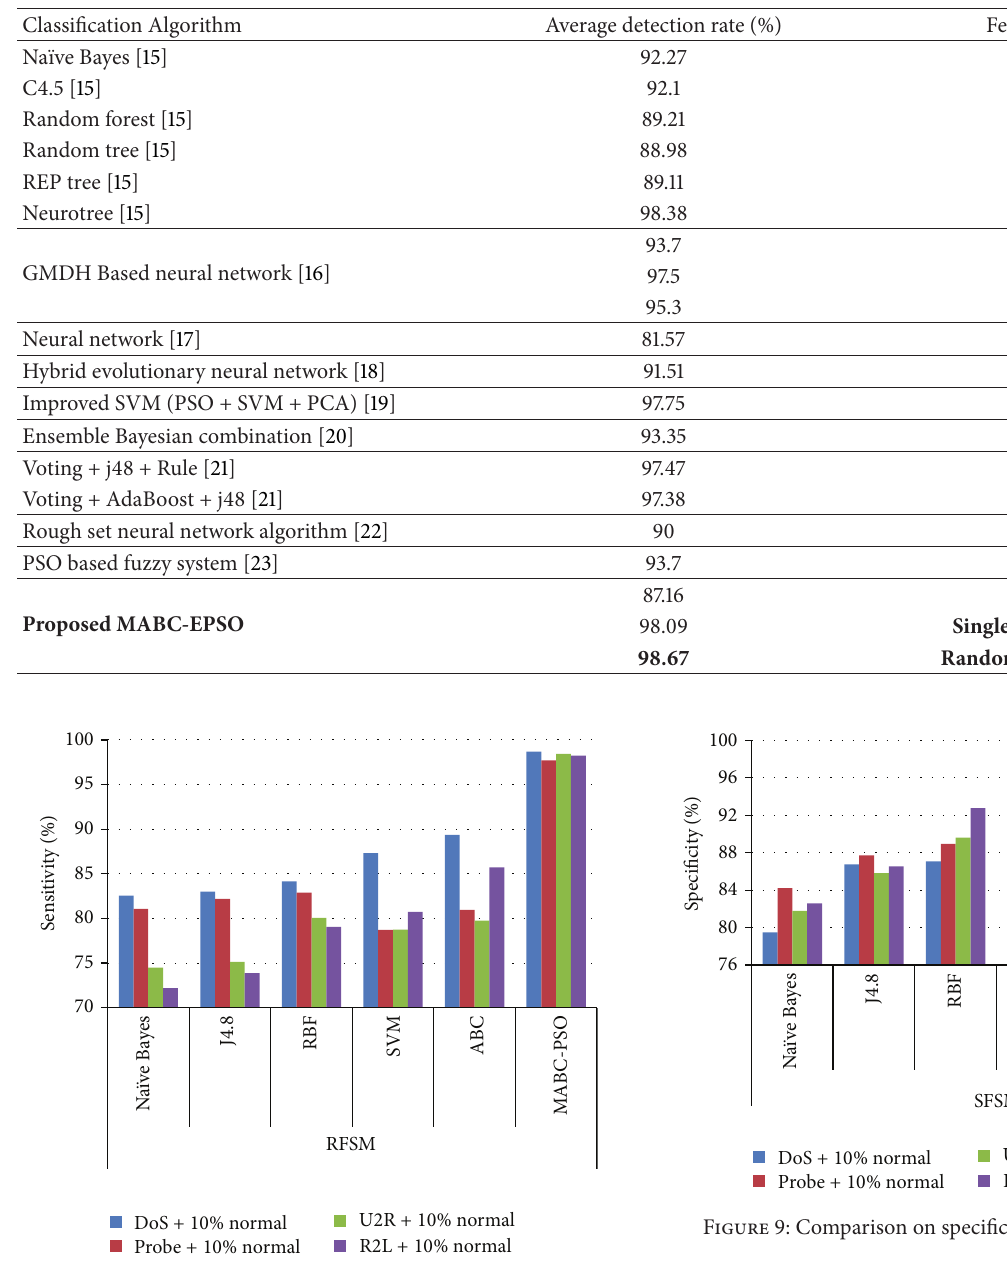
Table 12: Performance comparison of classification algorithms on detection rate.